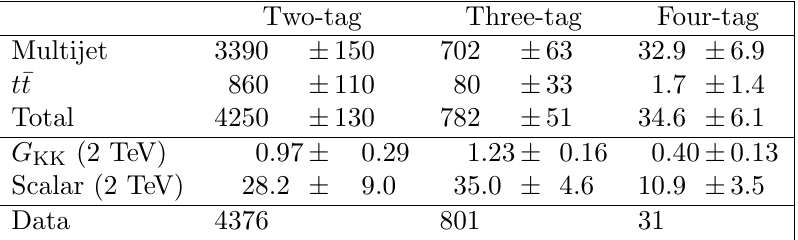
Table 7. The number of predicted background events in the signal region for the boosted analysis compared to the data, for the two-tag, three-tag, and four-tag samples. The yields for a 2 TeV scalar and a 2 TeV G KK with k=M Pl = 1 are also shown. The scalar is normalized to a cross section times branching ratio of 12 fb. The quoted uncertainties include both the statistical and systematic uncer- tainties. The anti-correlation between the multijet and t (cid:22) t yields is accounted for in the uncertainty in the total background yield.